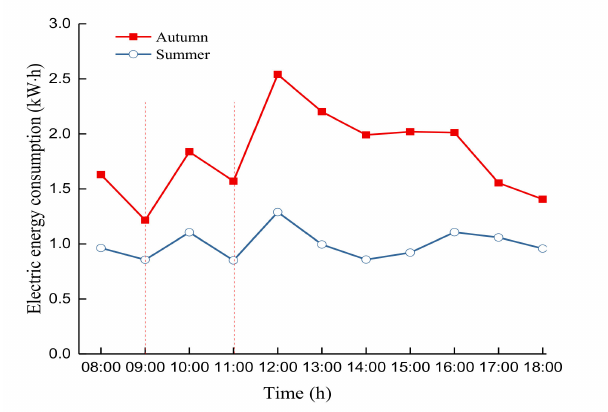
Figure 17. Hourly variation of electric energy consumption for one typical summer day and one typical autumn